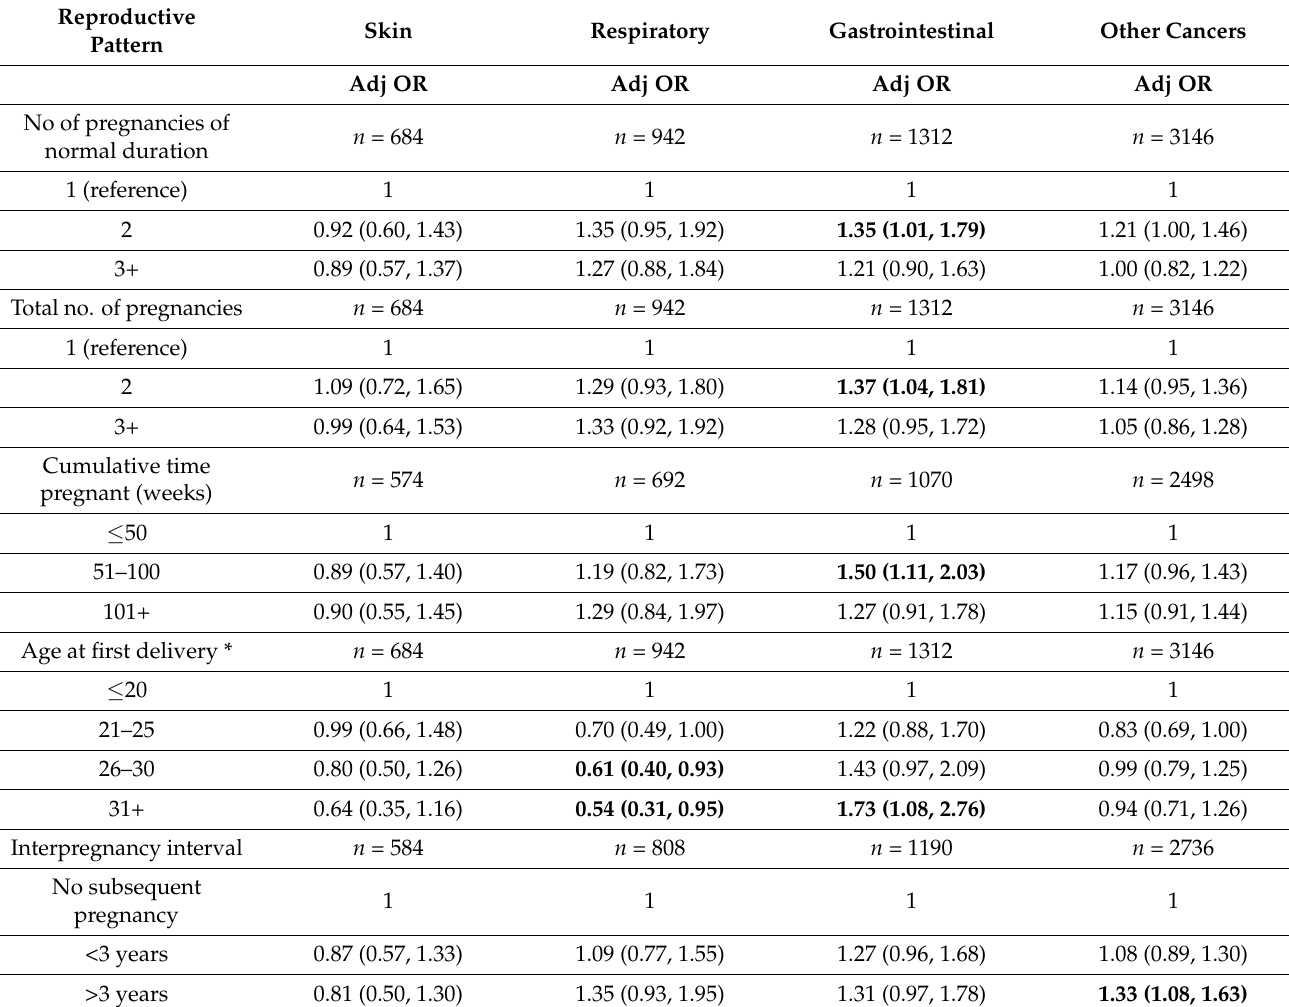
Table 4. Subgroup analyses by cancer site (non-gynaecological cancers): reproductive variables by case-control